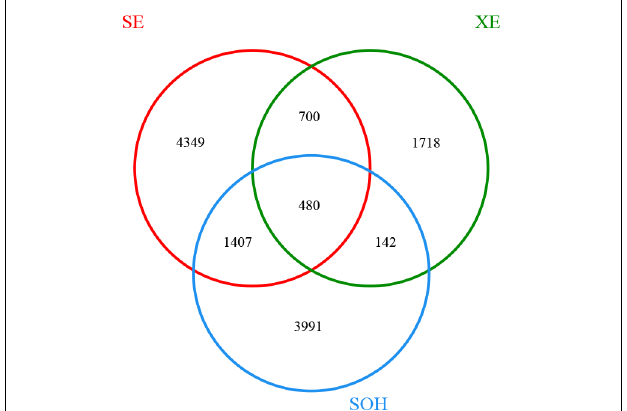
FIGURE 2 | Venn diagram was at a distance of 0.03. There were 6,936 OTUs in sample SE (five corrosion samples that were collected from Sanya and had been immersed in seawater for 8 years). There were 3,040 OTUs in sample XE (three corrosion samples that were collected from Xiamen and had been immersed in seawater for 8 years). There were 6,020 OTUs in sample